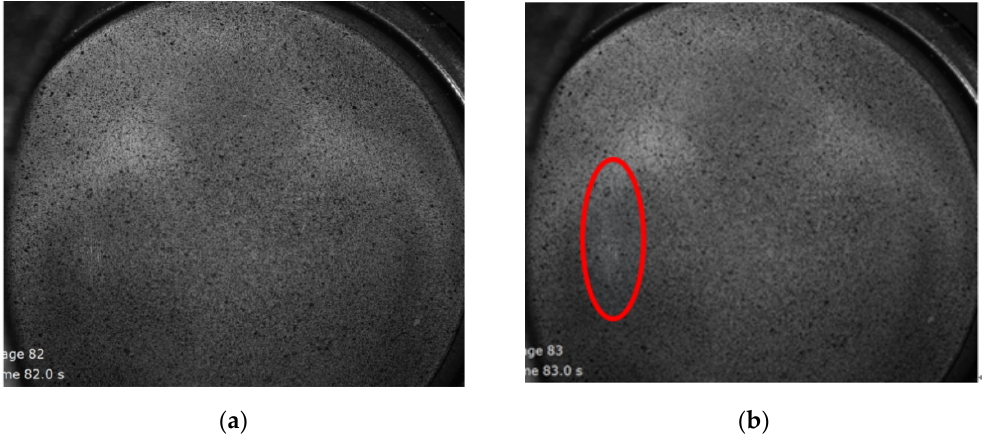
Figure 4. Surface of the deformed AA5754 tailor-welded blanks with thickness 3 mm: ( a ) prior to fracture (stage 82) and ( b ) after fracture (stage 83). The location of red circle is the fracture location.